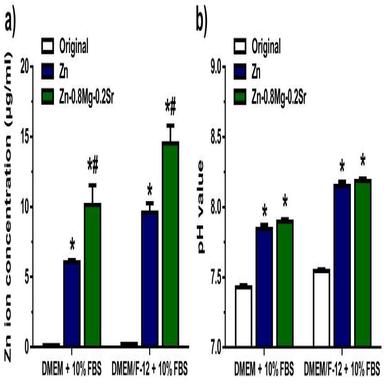
Analysis of pure Zn and Zn-0.8Mg-0.2Sr specimens incubated in DMEM + 10% FBS and DMEM/F-12 + 10% FBS under cell culture conditions for 24 h. a) Zn ion concentration (μg/ml) of samples (n = 4), determined by ICP-OES. b) Measurement of pH values (n = 4). \ and # represent p < 0.05 by one-way ANOVA followed by post hoc Tukey's test, when compared to the original media and Zn extracts, respectively.